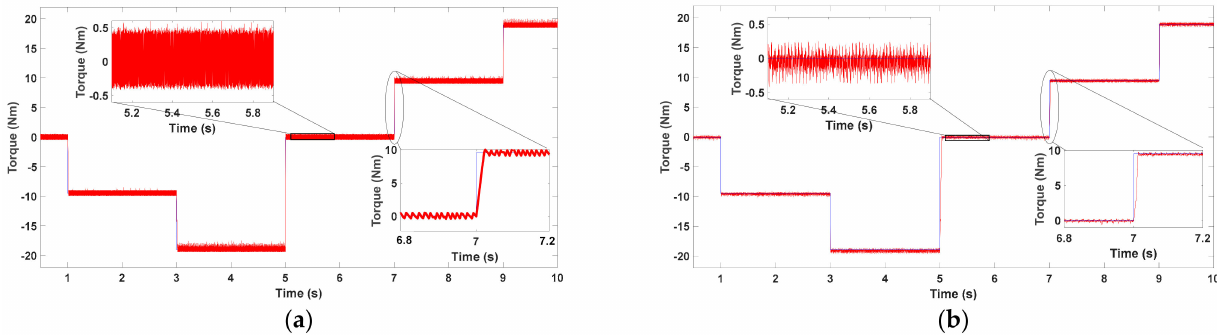
Figure 15. Electromagnetic torque response with ( a ) 6 − sectors and ( b ) 12 − sectors DTC control